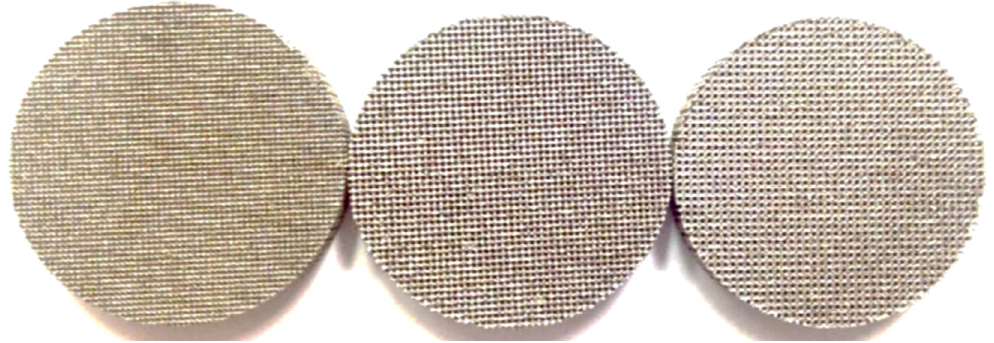
Figure 12. Photo of AM wicks [39].